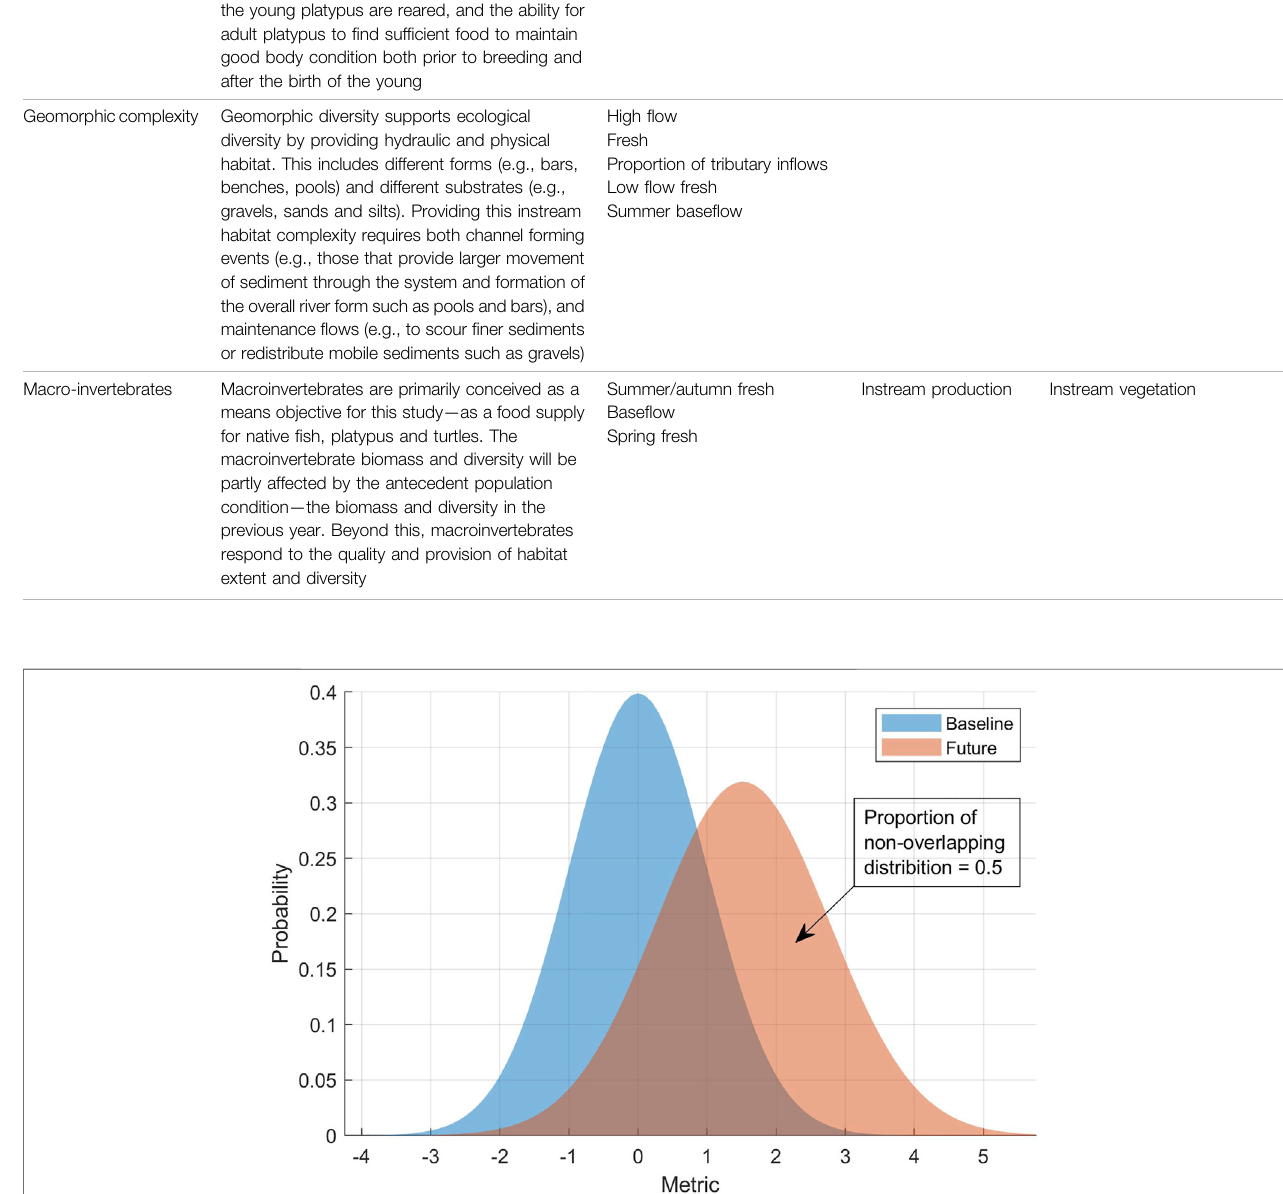
Frontiers in Environmental Science |